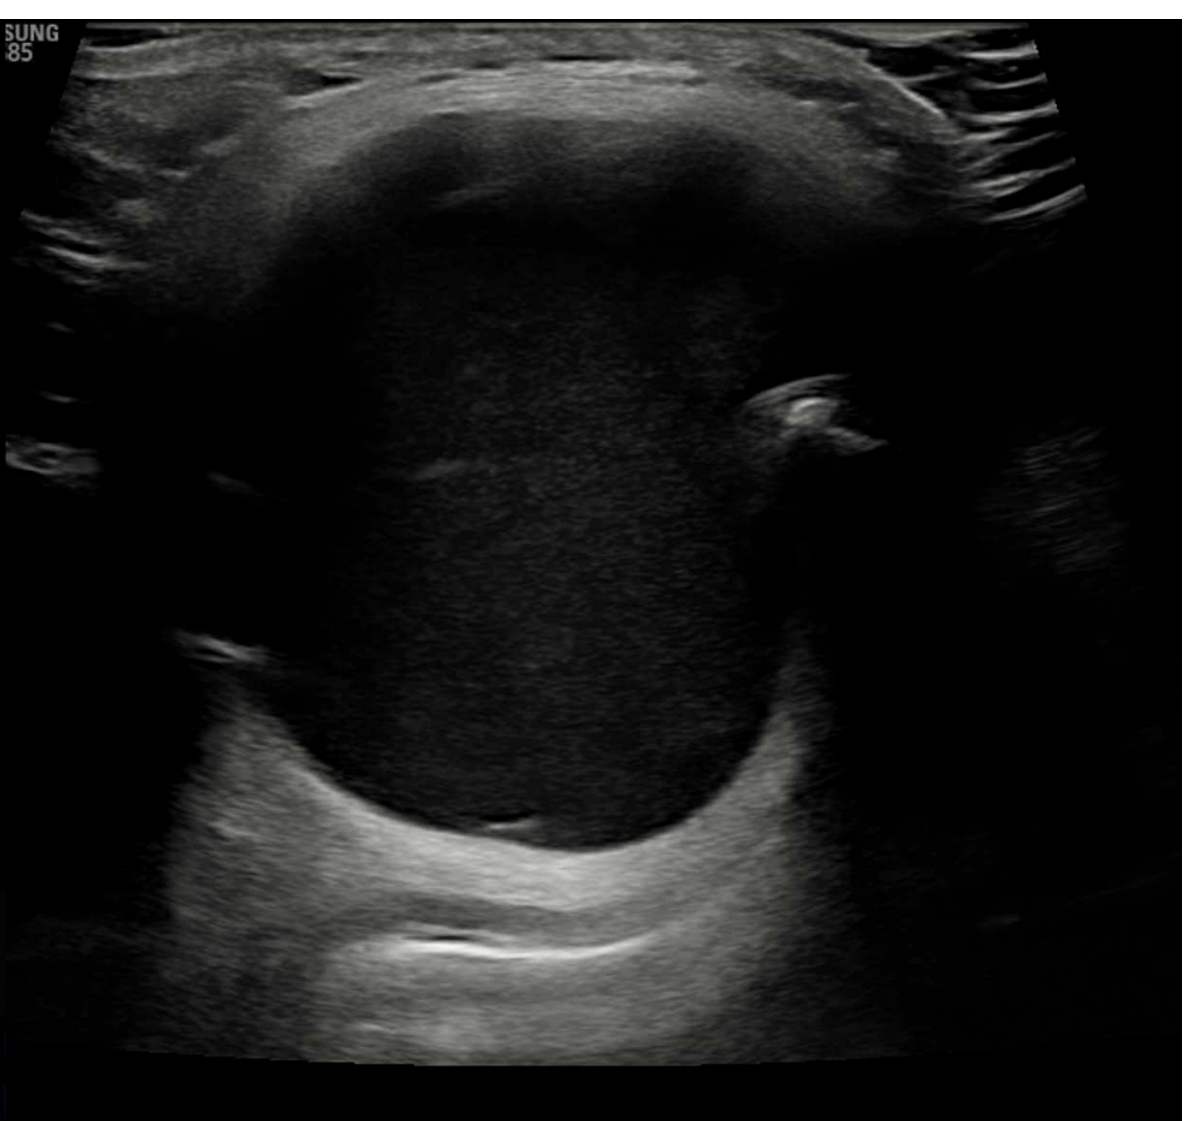
Figure 2. Ultrasound image showing echo-normal and homogeneous thyroid gland. Magnetic resonance imaging (MRI) of the neck’s soft tissues (native and IV KM) diagnosed it as a suprahyoid thyroglossal cyst located posterior to the platysma, as it appeared hyperintense in T2 with isointense parts and was also isointense in T1 with an extension of approximately 0.041 m × 0.044 m × 0.033 m. There was minimal displacement of the hypopharynx and epiglottis with no evident connection to the thyroid gland or the tongue’s base. There was also discreet contrast-medium uptake of the wall and protein-rich fluid, indicating possible previous inflammation. We found no cervical lymphadenopathy, and the submandibular gland and parotid gland were inconspicuous. In the cervical spine, as shown in Figure 3, no significant degenerative changes could be